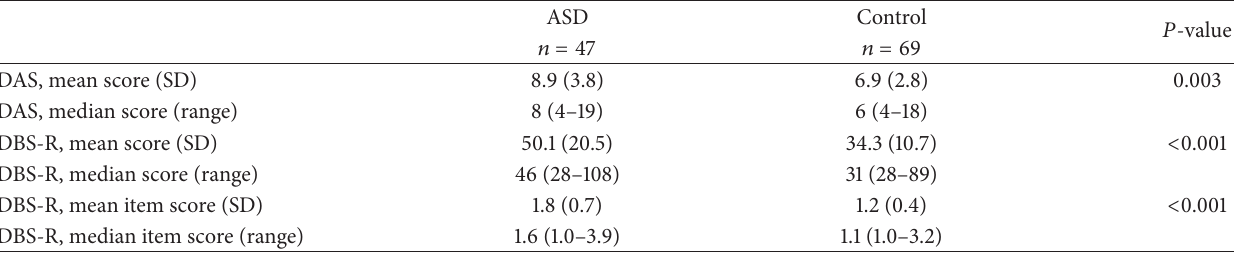
Table 4: Dental anxiety and beliefs in autism spectrum disorder (ASD) and